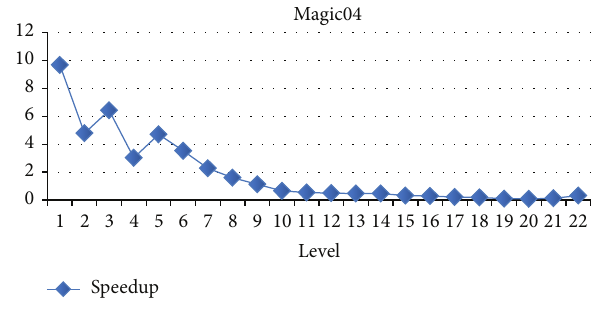
Figure 18: Speedup of level of Magic04.